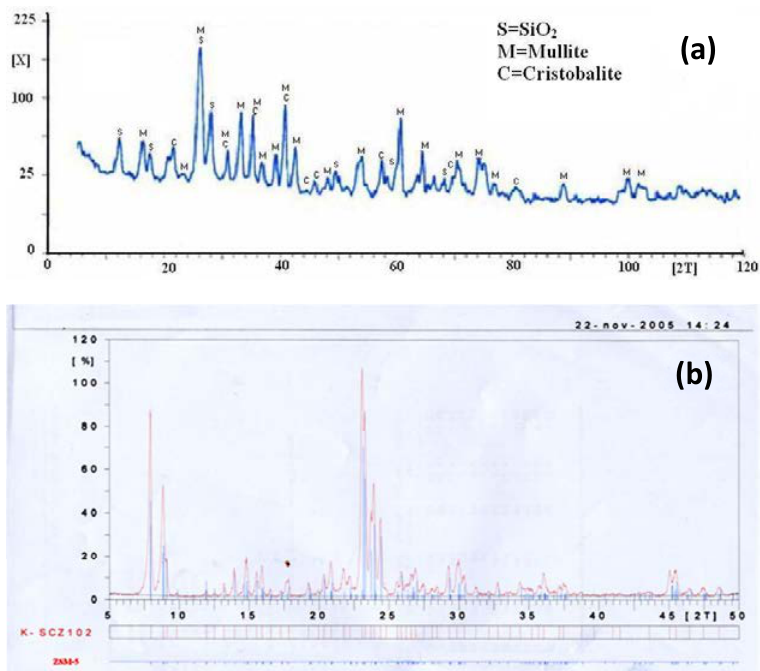
Fig. 5: XRD patterns of the (a) support and (b) ZSM-5 zeolite membrane